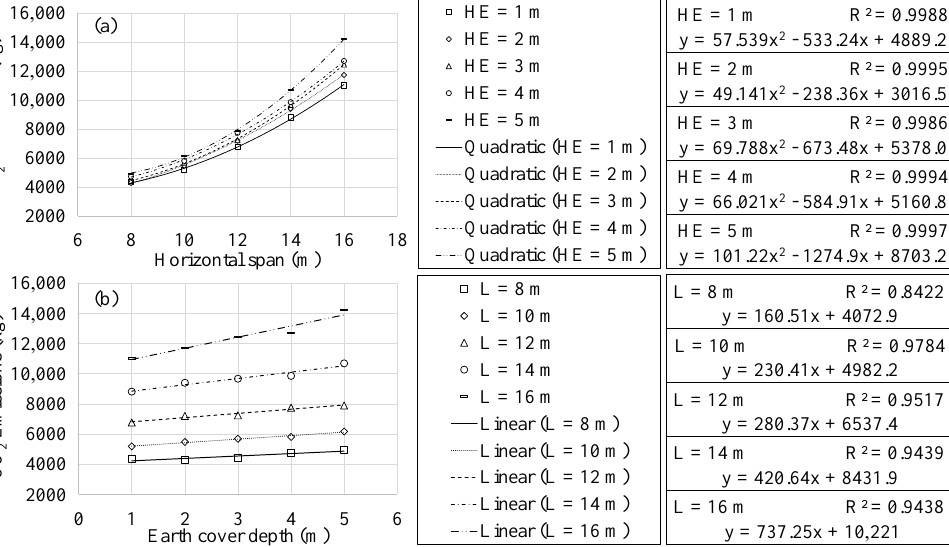
Figure 5. Associated CO 2 emissions analysis as a function of: ( a ) horizontal span; ( b ) earth